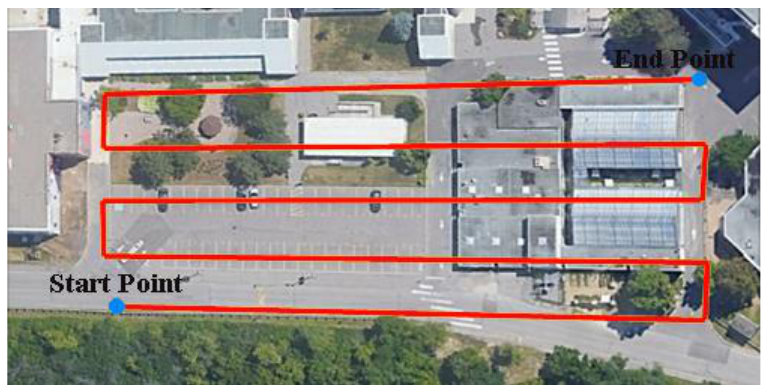
Figure 2. UAS flight lines above the study